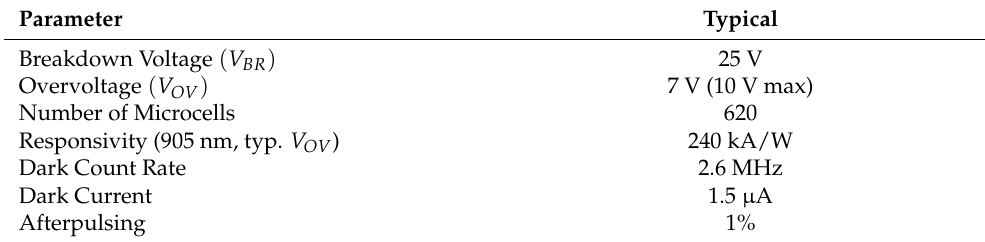
Figure 10. Measuring chamber ( a ) and the SiPM fixture ( b ). Table 1. Main parameters of